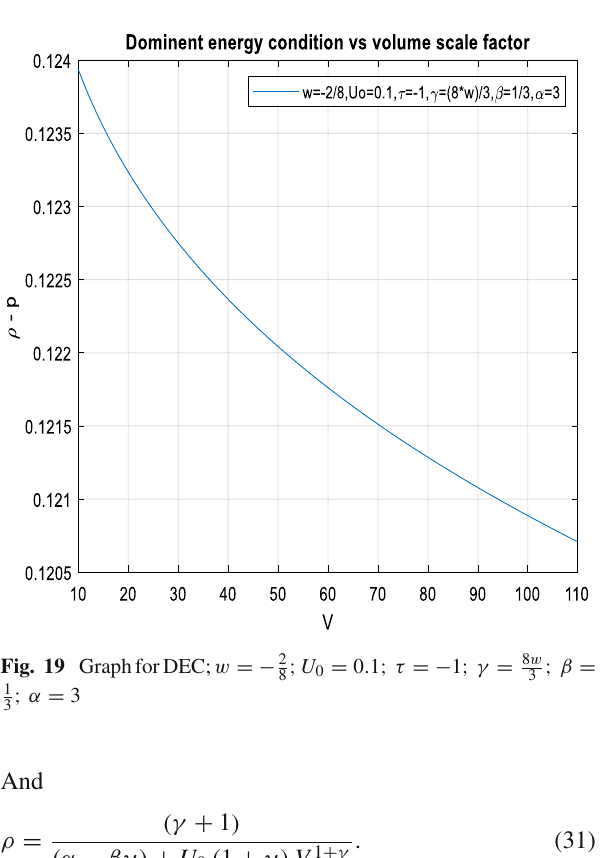
Fig. 20 Graph for WEC; w = − 2 8 w